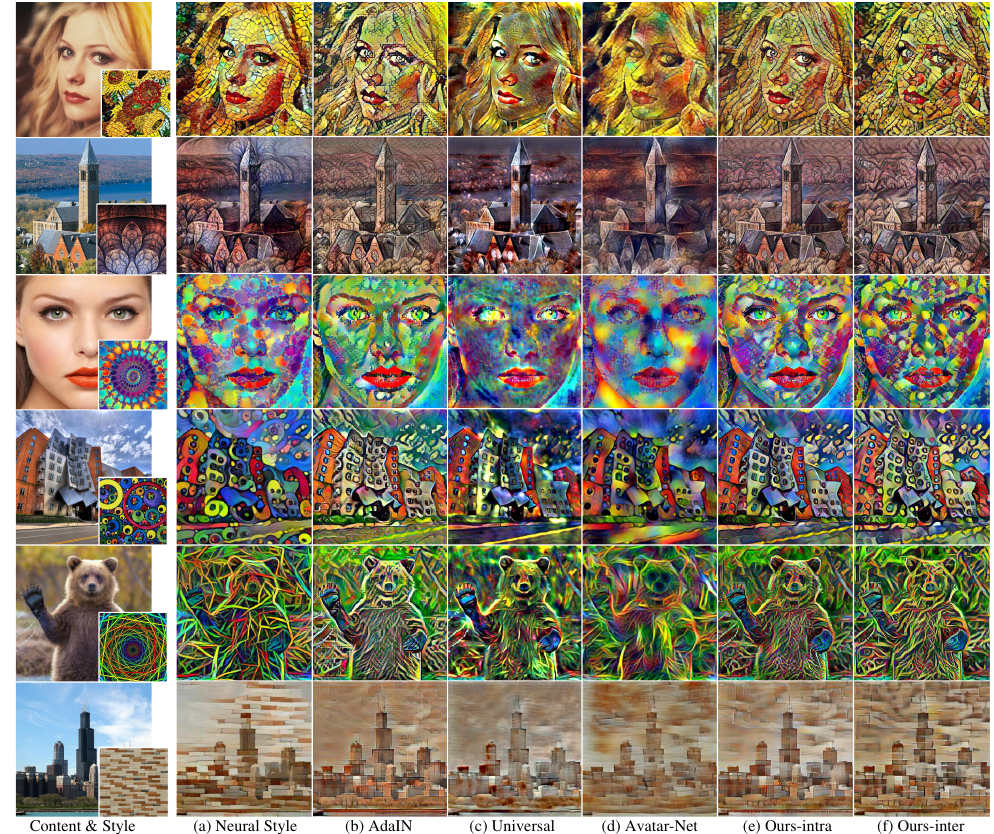
Figure 4. Output stylized images of the existing methods and our method with VGG16-based network structures. The target style images were not used for network